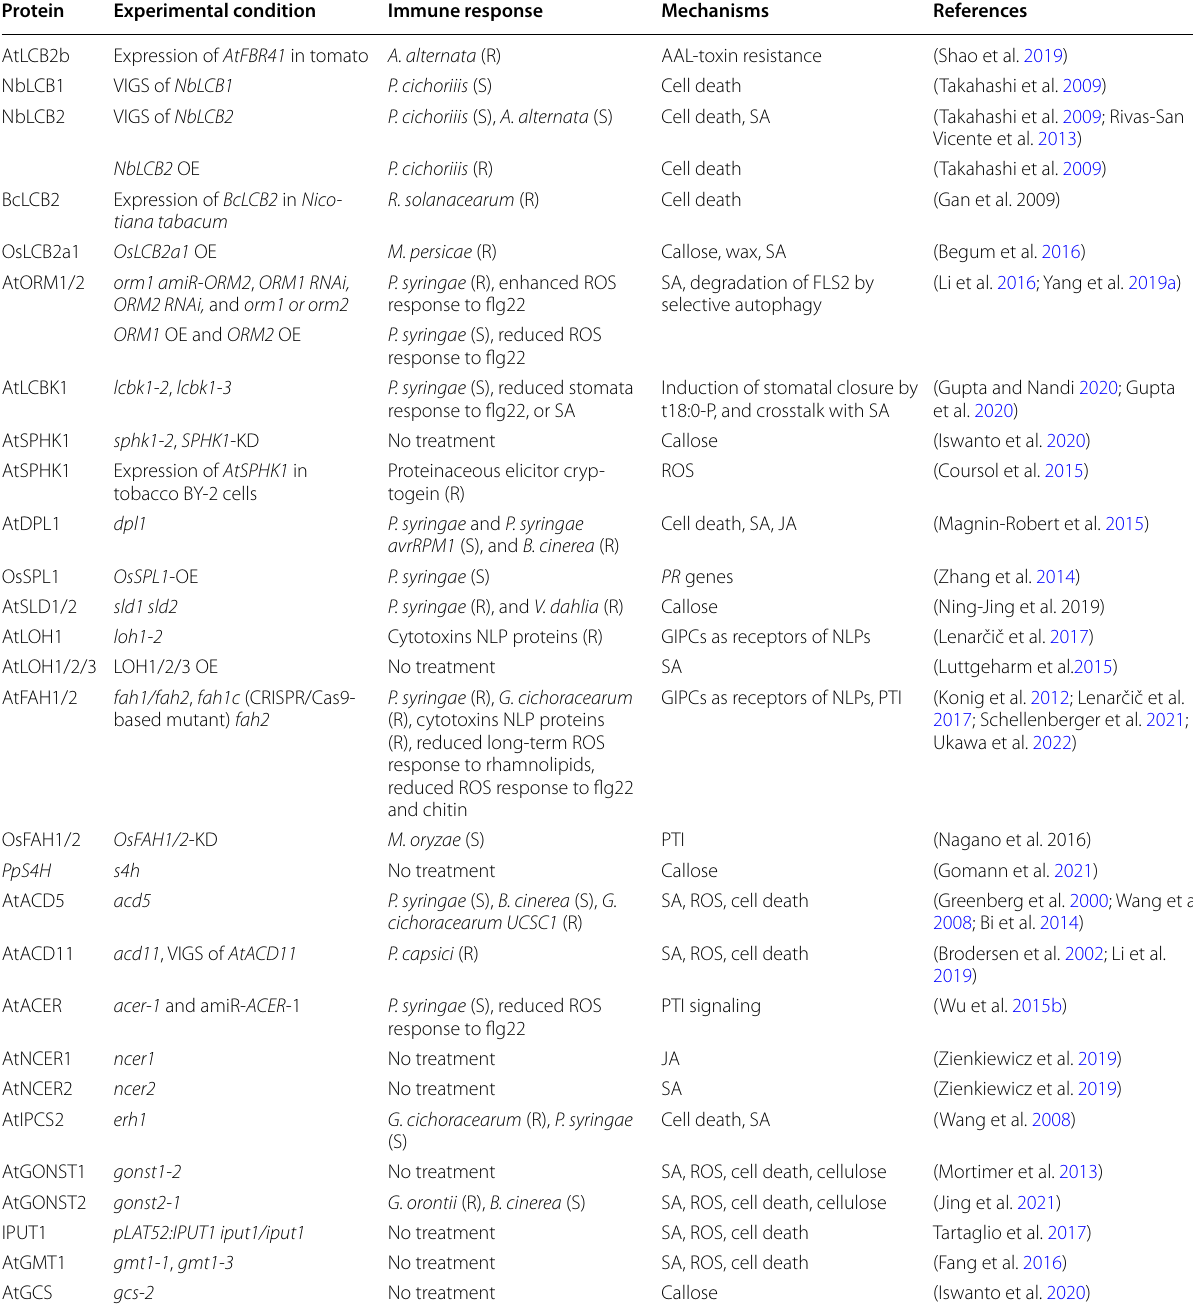
Table 3 Sphingolipid metabolism‑related proteins involved in plant